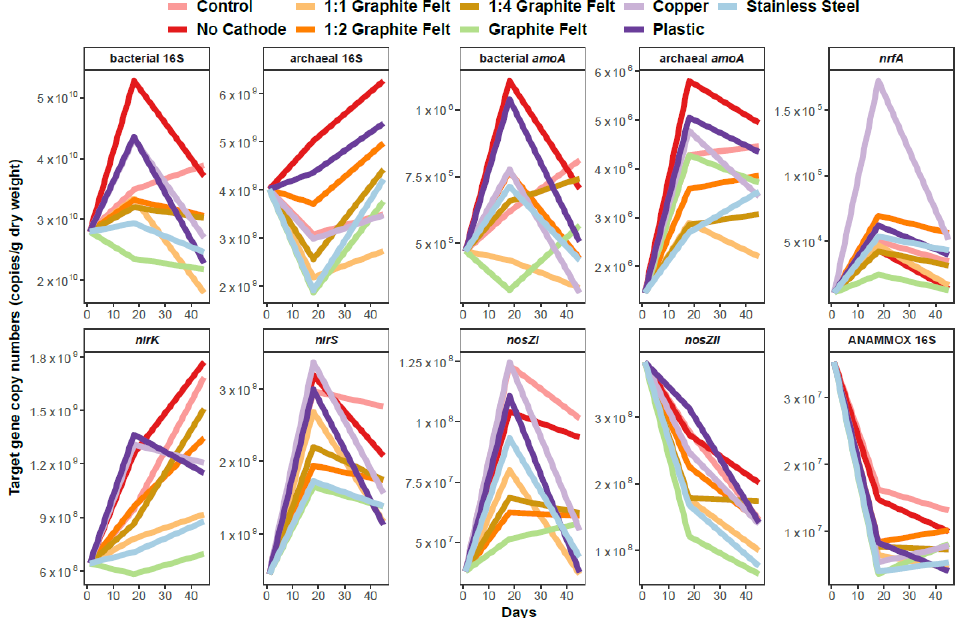
Figure 5. Temporal dynamics of different gene abundances during the experiment (each n = 3). nirS , nirK , nosZI , nosZII , bacterial and archaeal amoA , ANAMMOX-specific 16S rRNA genes were detected in all sediment samples, whereas nrfA genes were not detected in sediments of one parallel of No Cathode, Graphite Felt, and 1:2 Graphite Felt treatments (Figure 4; Supplementary Figure S2). Based on average values of the gene parameters, the abundances of the functional gene